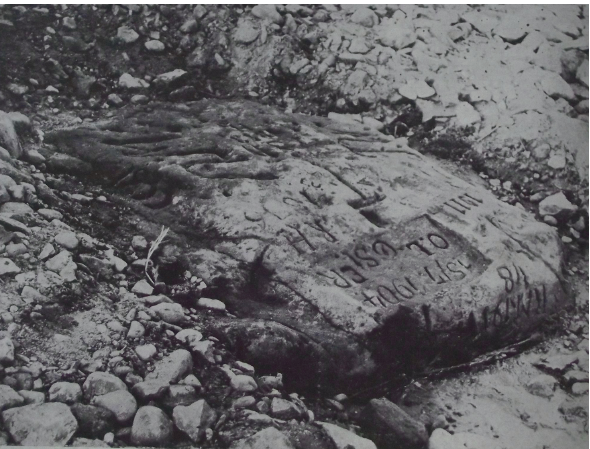
Figure 8. Picture from ˇCeský svˇet magazine, no. 51, dated 25 Au- gust 1911. It shows a completely unknown hunger stone. The fol- lowing years are engraved: 1835, 1904, 1911, 1873 and 1(?)76 (1576, 1876 or 1516?). This picture was found in the National Mu- seum archive by Zvonimír Dragoun. The locality is unknown, and the existence is